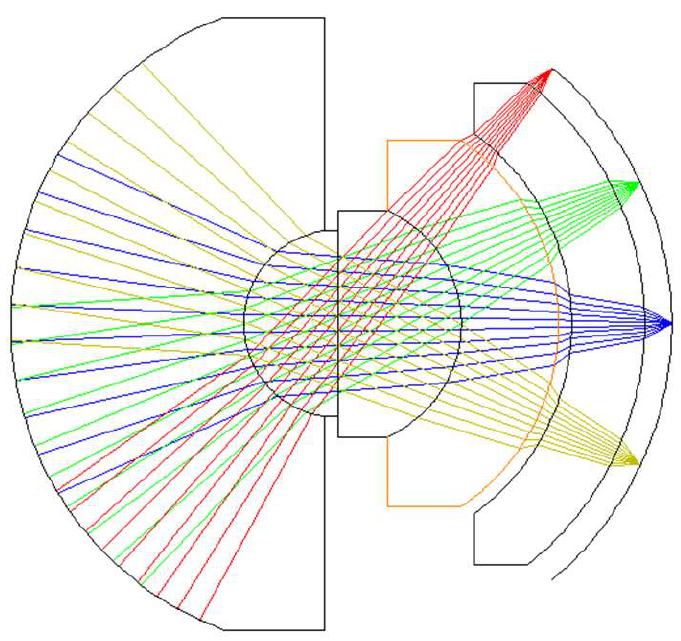
Figure 6. Structure of the designed system. Table 2. Parameters of the monocentric lens.